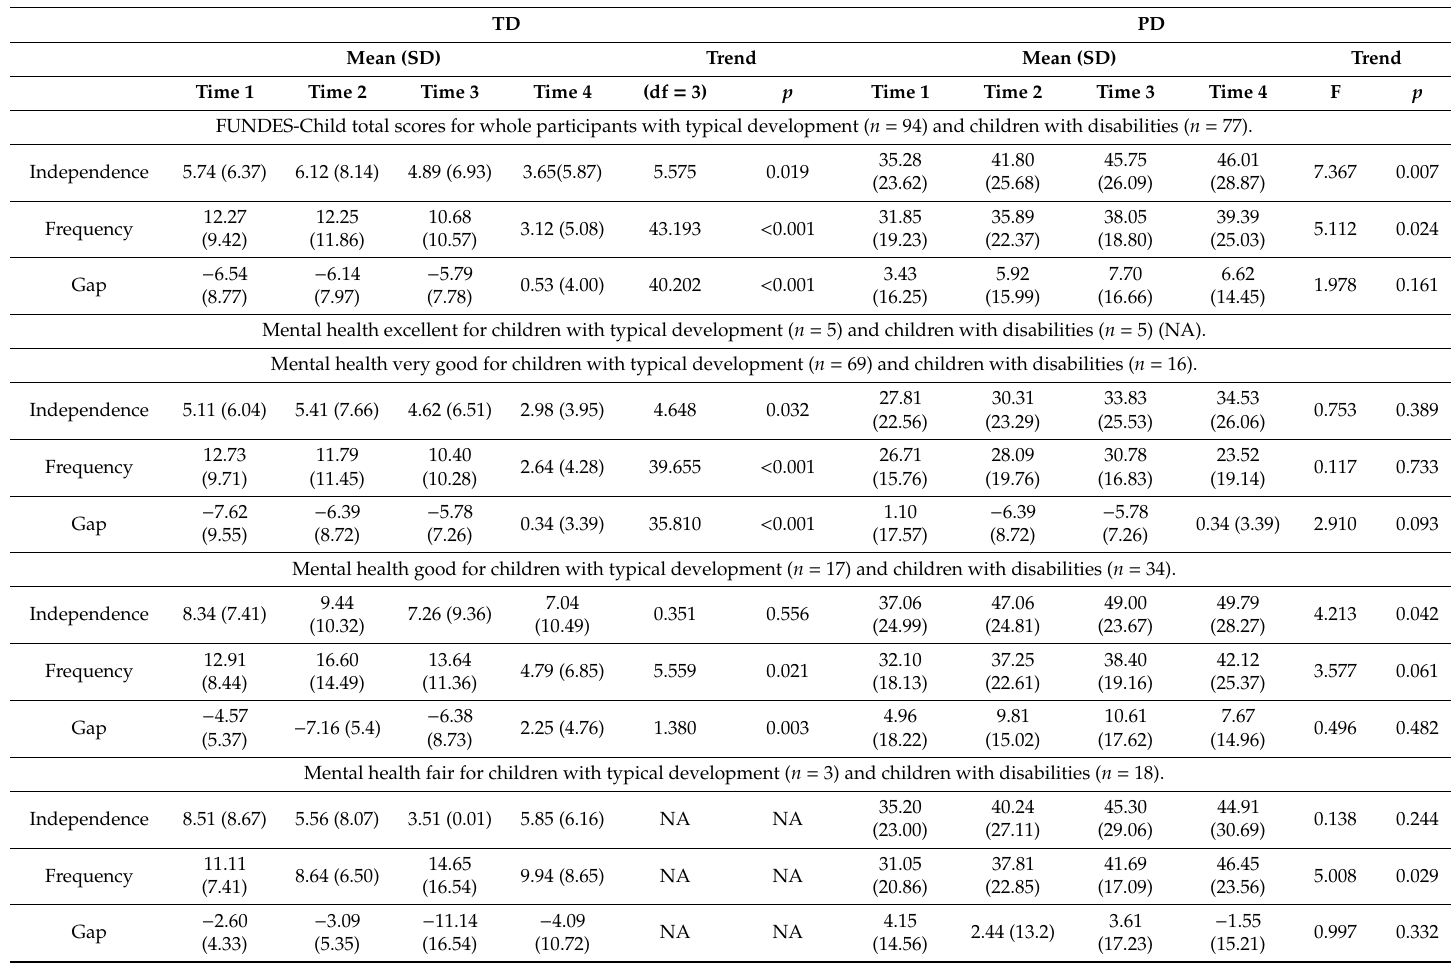
Table 2. Results of longitudinal statistical analyses for children with PD and TD